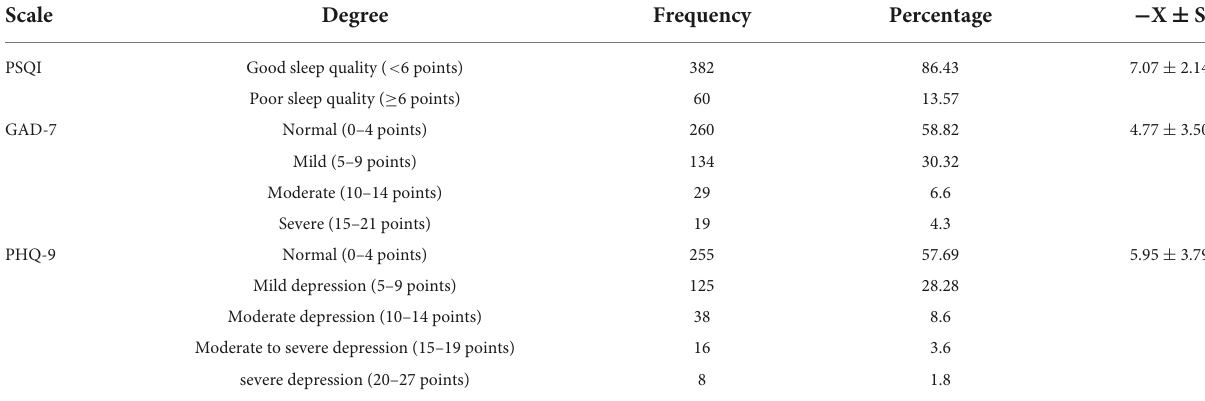
TABLE 1 Survey results of sleep quality and anxiety and depression among nurses in infectious disease specialist hospitals.